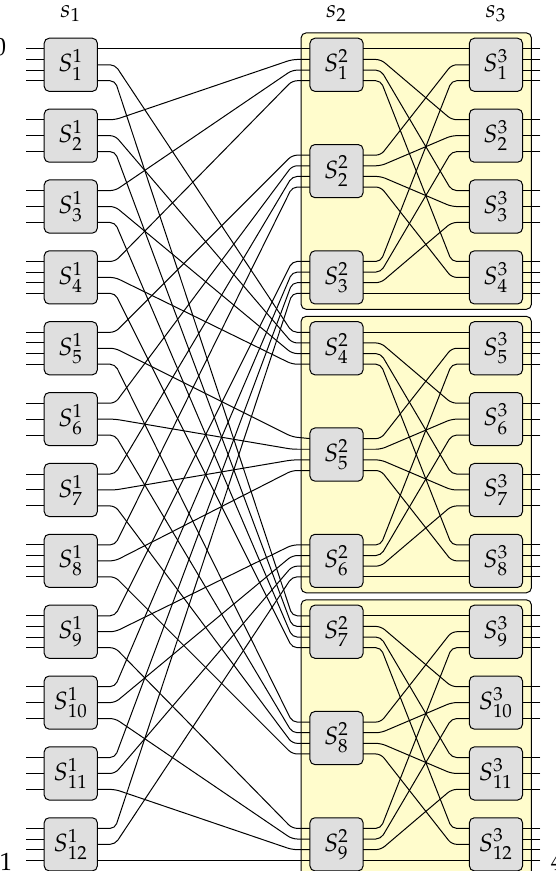
Figure 3. The MBA ( 42,4,3 ) switching